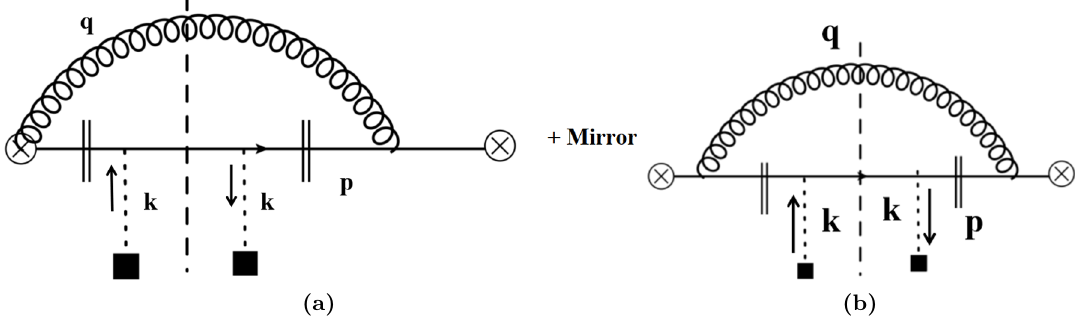
Figure 3. Real emission diagrams for the medium induced jet function. The ⊗ is the hard vertex that creates the quark. The Gluon in diagram (a) is from the n collinear Wilson line attached to the hard vertex. The dotted line indicates the Glauber gluon exchange with the medium. We also indicate that the quark goes on-shell before interacting with the medium. Diagram (b) comes from insertions of H which describes interactions between n collinear n, int